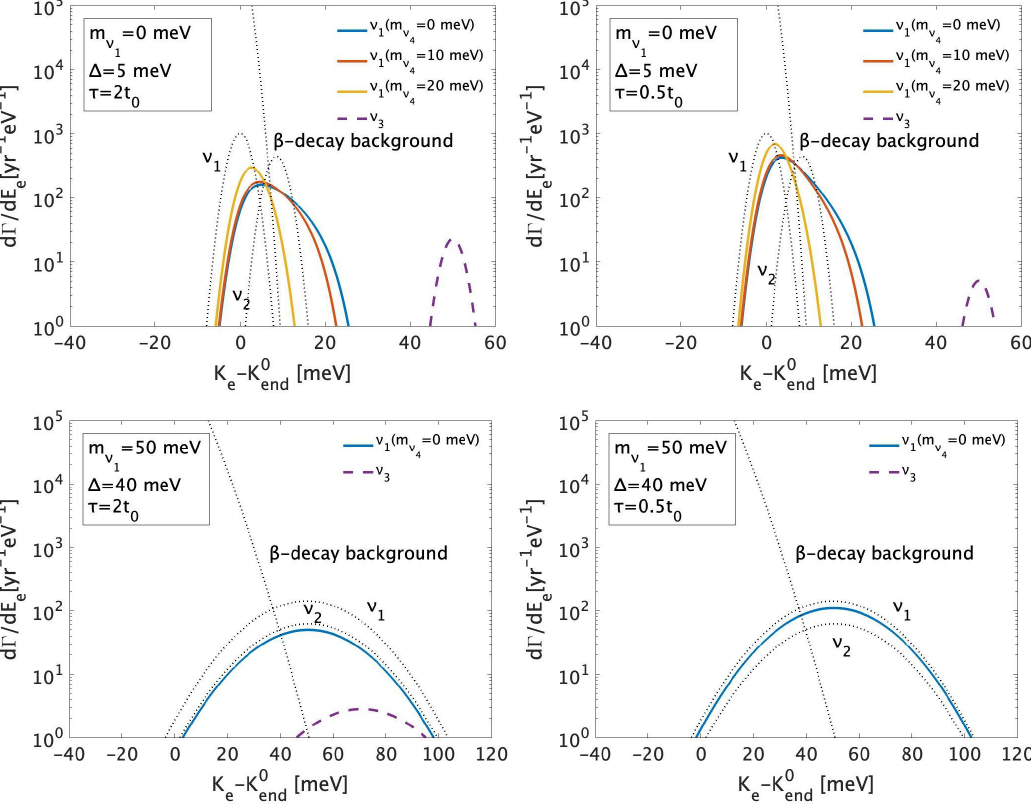
Figure 5 . The expected spectra from the 3-body decays, ν 3 → ν 1 ν 4 ¯ ν 4 , in the neutrino capture on 100 g of tritium for the NO case. We set ( m ∆ , τ ) = (0 meV , 5 meV , 2 t ) (top left ν 1 , ν 3 0 panel), (0 meV , 5 meV , 0 . 5 t ) (top right panel), (50 meV , 40 meV , 2 t ) (bottom left panel) and 0 0 (50 meV , 40 meV , 0 . 5 t ) (bottom right panel) with several values of m . Blue, red and yellow lines 0 φ denote the spectra for ν produced by the decays of ν for m = 0 , 10 , 20 meV , respectively. A 1 3 ν 4 purple dashed line denotes the spectrum for ν produced in the early universe but suppressed by 3 the decays of ν . Black dotted lines denote the contributions of the spectra for ν and ν produced 3 1 2 in the early universe and β -decay background. Note that the actual spectrum is a superposition of these